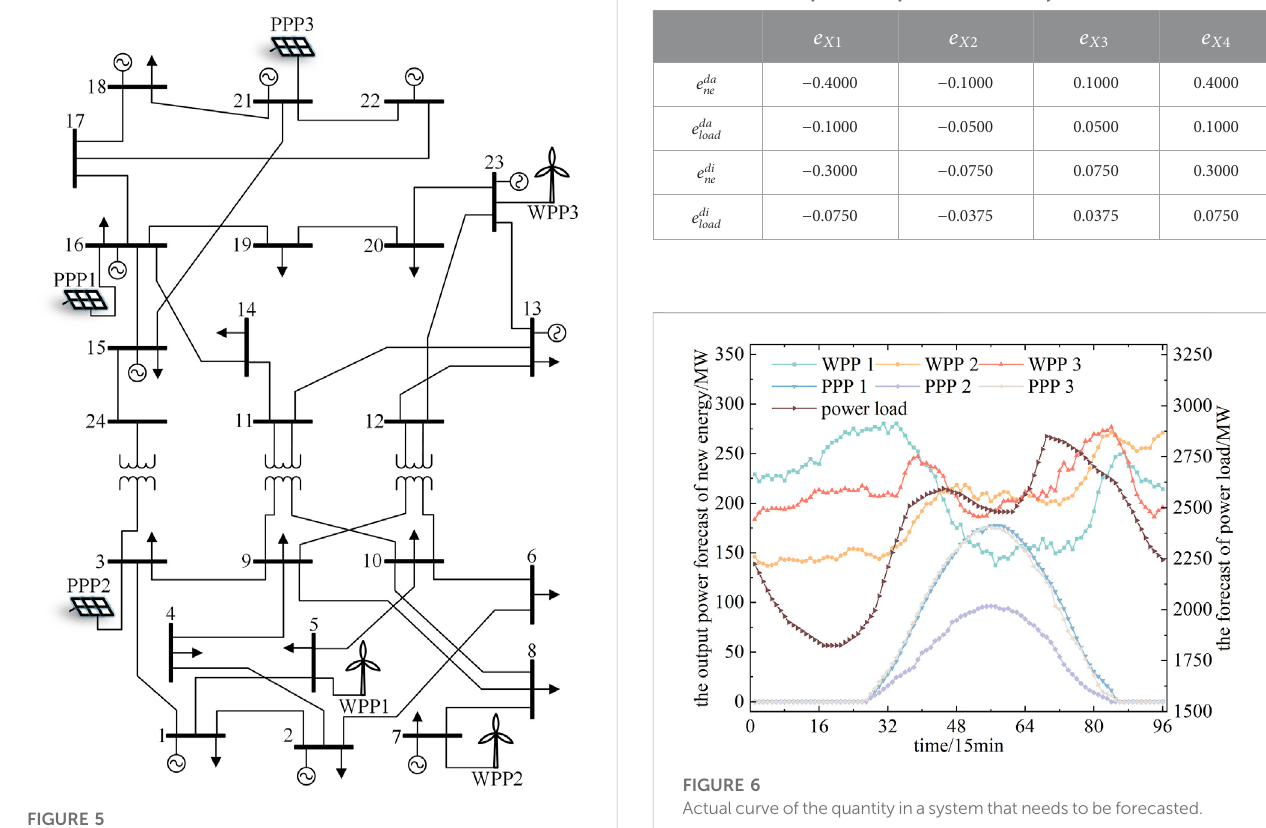
TABLE 3 Membership function parameters of fuzzy